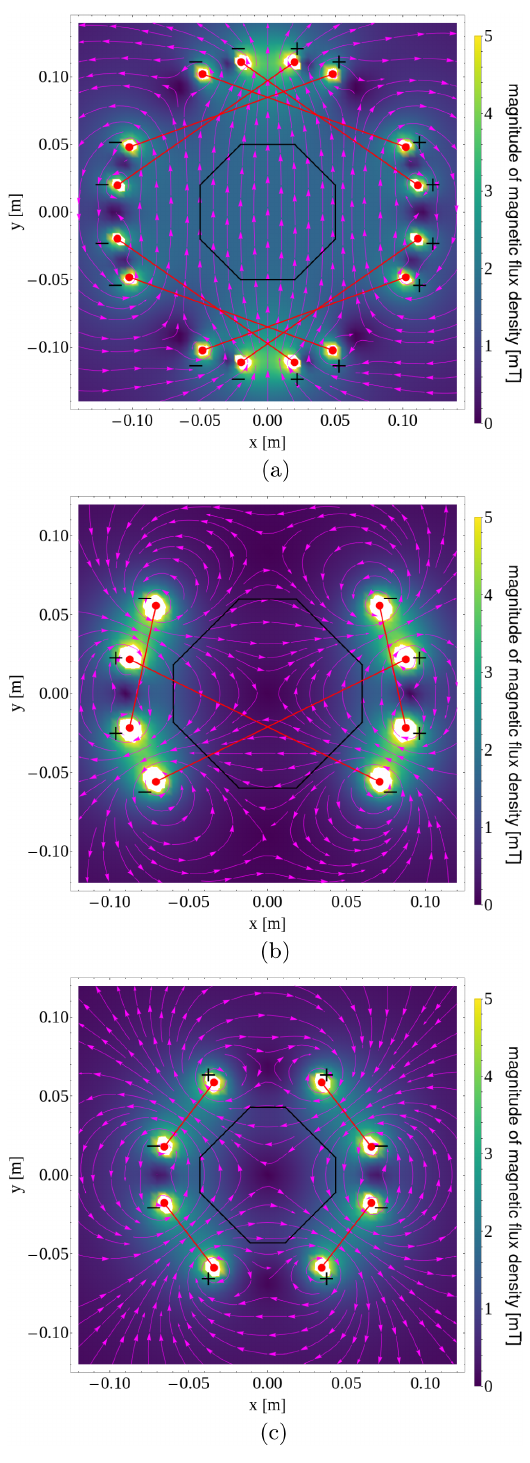
FIG. 5. Magnetic fields during nominal QH discharges in selected HL-LHC magnets as calculated with a Biot-Savart model. The red points show the position of the QHs and the red lines show which QHs are connected to each other. The QH polarities are indicated by black þ and − . The beam screen is shown for reference, but not used for the calculations. (a) Triplet quadrupoles (Q1 beam screen) (b) D1 separation dipole (c) D2 recombination